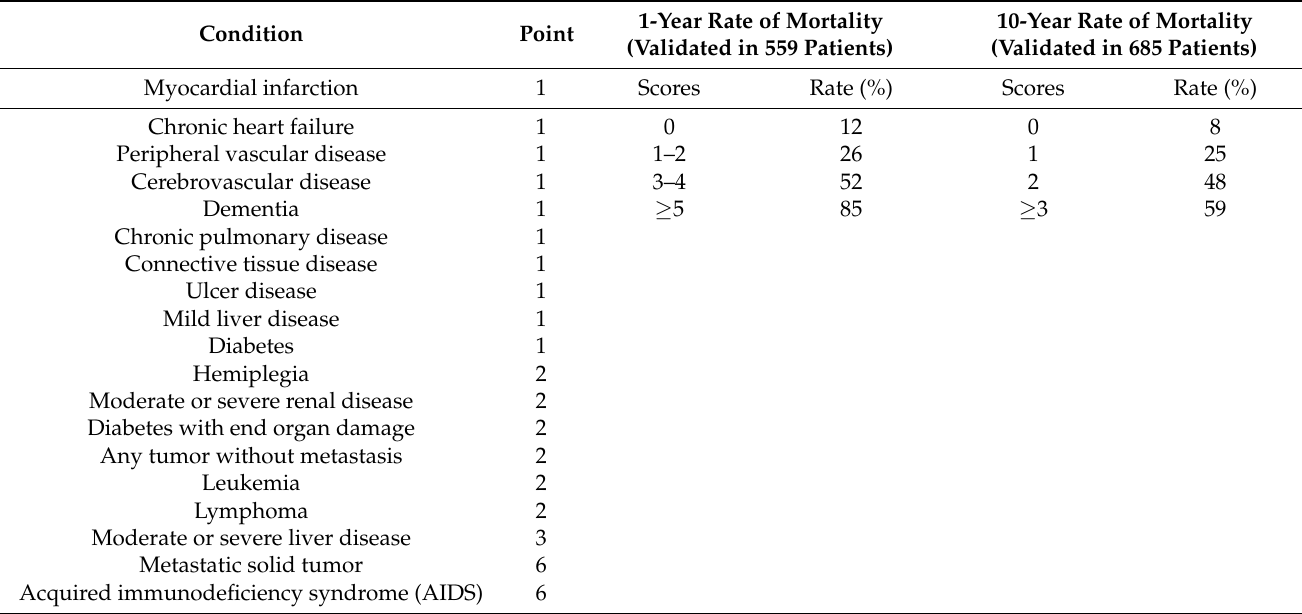
Table 1. Charlson comorbidity index (CCI) and the risk of one-year and ten-year mortality [10].